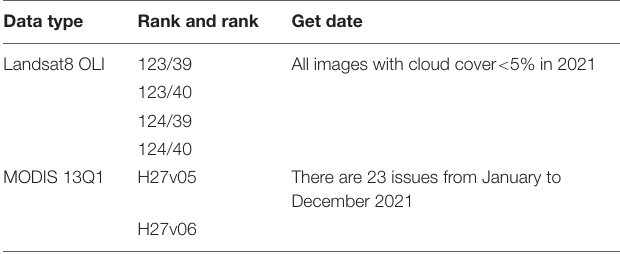
TABLE 1 | Remote sensing data.